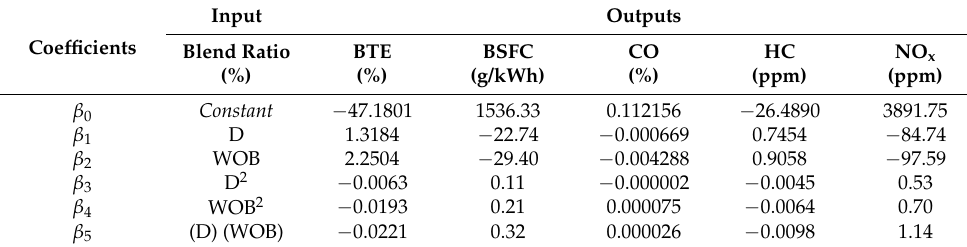
Table 6. The mathematical equations of the outputs.